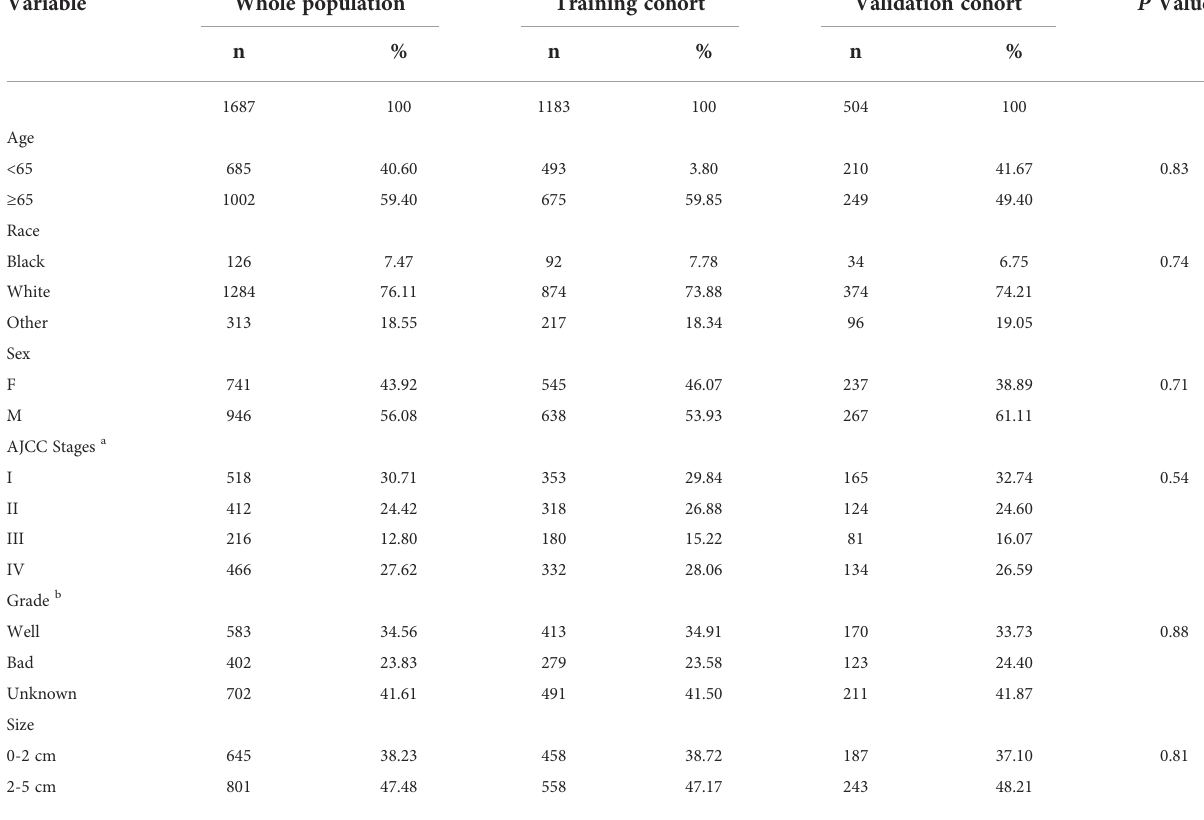
TABLE 1 Demographics and clinical characteristics of ECCA at